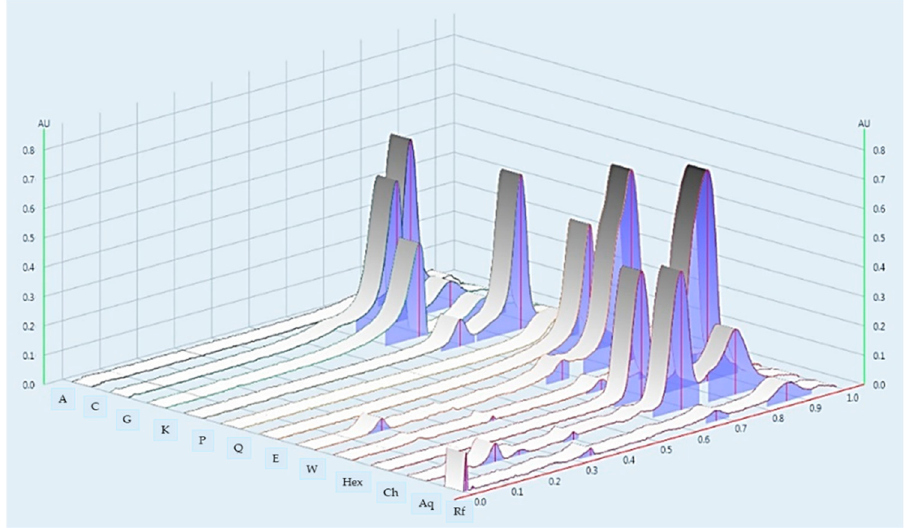
Figure 4. HPTLC Chromatogram at 254 nm. A = apigenin; C = caffeic acid; G = gallic acid; K = kaemferol; P = pinene; Q = quercetin; E = ethanolic crude extract; W = water crude extract; Hex = n-hexane fraction; Ch = chloroform fraction; and Aq = aqueous alcohol fraction. Rf, rate of flow; AU, absorbance units.